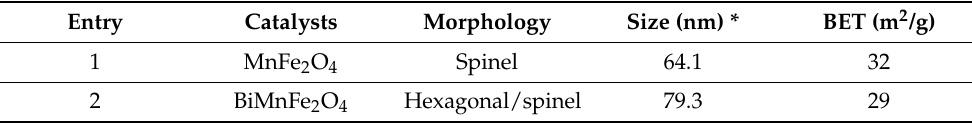
Figure 2. ( a , b ): SEM images of MnFe 2 O 4 at different magnifications; ( c , d ): EDX spectra and elemental Figure 2. ( a ) and ( b ): SEM images of MnFe 2 O 4 at different magnifications; ( c ) and ( d ): EDX spectra analysis of MnFe 2 O 4 ; ( e , f ): SEM images of Bi doped MnFe 2 O 4 at different magnifications; ( g , h ): EDX and elemental analysis of MnFe 2 O 4 ; ( e ) and ( f ): SEM images of Bi doped MnFe 2 O 4 at different mag- nifications; ( g ) and ( h ): EDX spectra and elemental analysis of Bi-MnFe 2 O 4. spectra and elemental analysis of Bi-MnFe 2 O 4. Table 1. Morphology, particle size and surface area of catalysts. Table 1. Morphology, particle size and surface area of